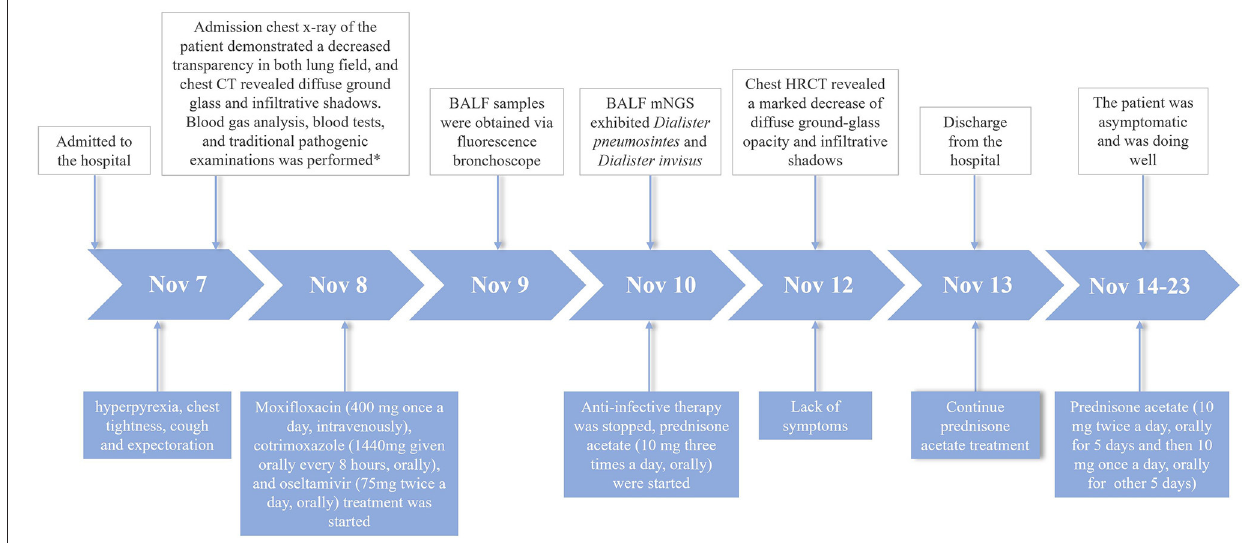
FIGURE 2 | Case history of the patient with ARDS caused by occupational exposure to waterproofing spray. *The blood tests included complete bloodcount, serologic tests (c-reactive protein, procalcitonin, d-dimer); Traditional pathogenic examinations included sputum culture, nucleic acids of respiratory pathogens, sputum smear for acid-fast bacillus, and laboratory investigations of respiratory pathogens serum